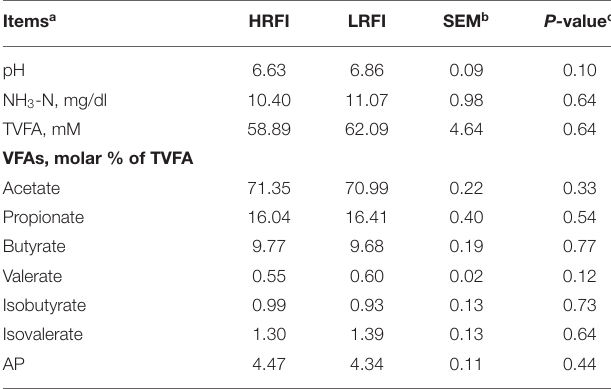
TABLE 2 | Rumen fermentative parameters of Angus heifers according to RFI